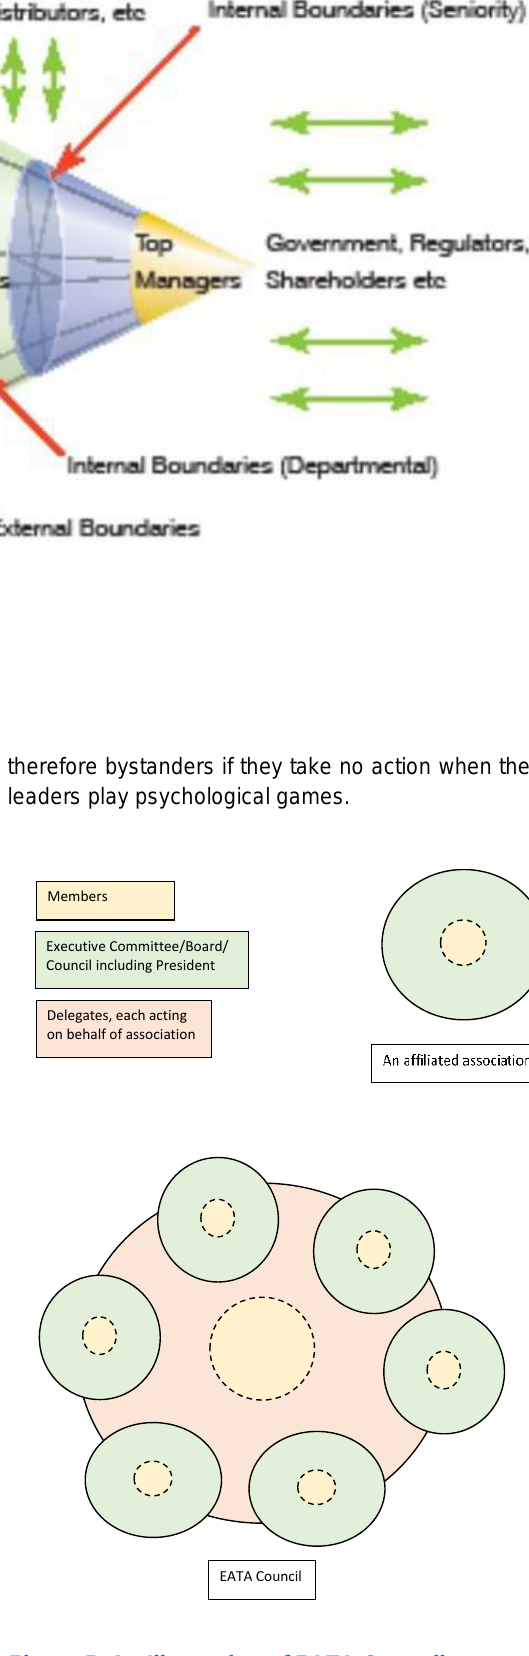
Figure 5: An Illustration of EATA Council